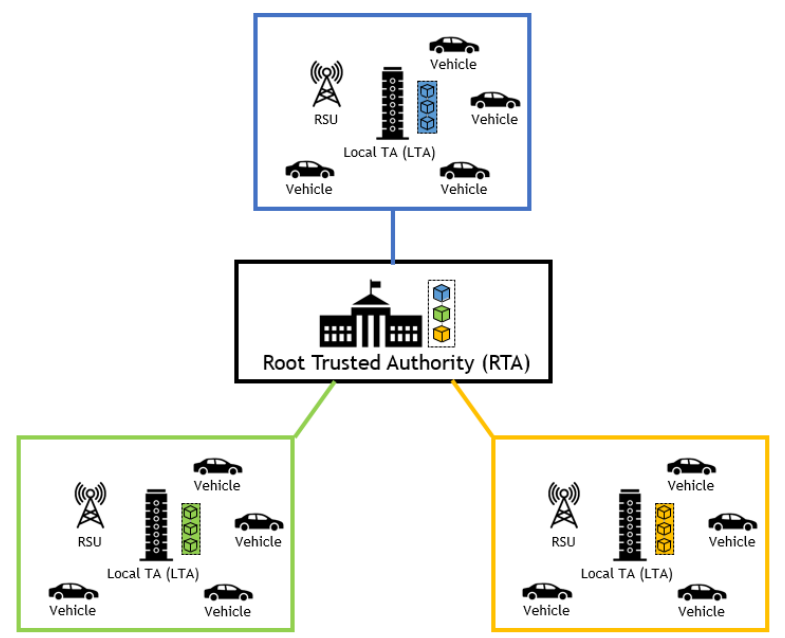
Figure 3. Considering network